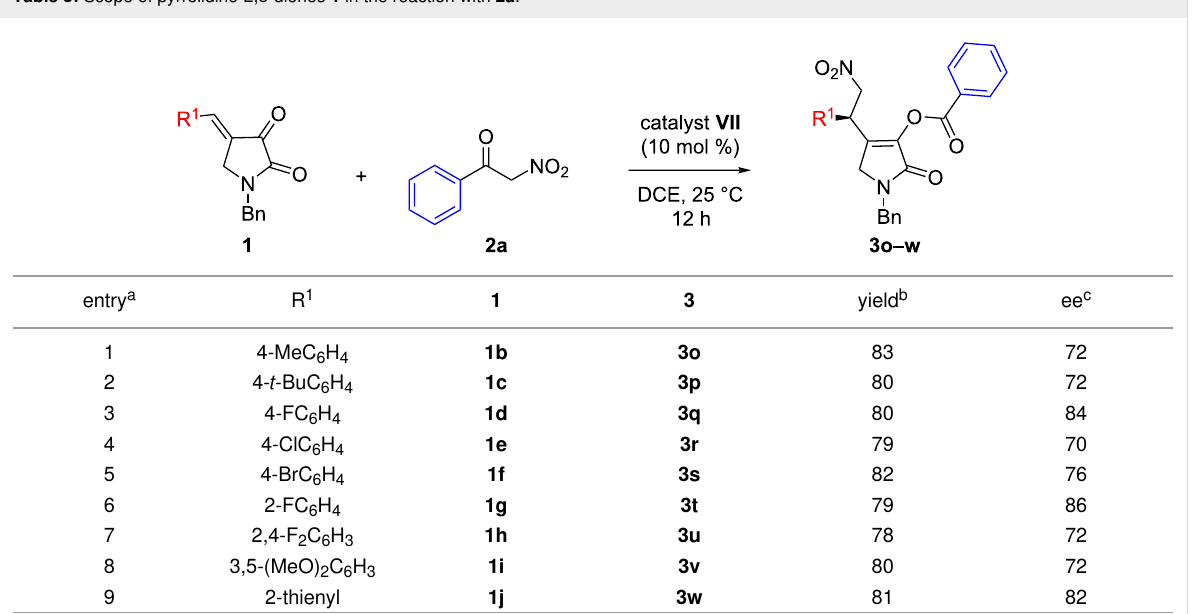
Table 3: Scope of pyrrolidine-2,3-diones 1 in the reaction with 2a